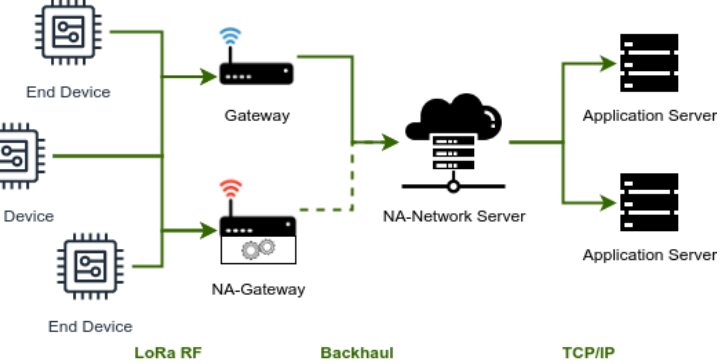
Figure 2. Architecture of a hybrid LoRaWAN scenario. Blue signal indicates traditional LoRaWAN gateway and red signal indicates a NA-LoRaWAN